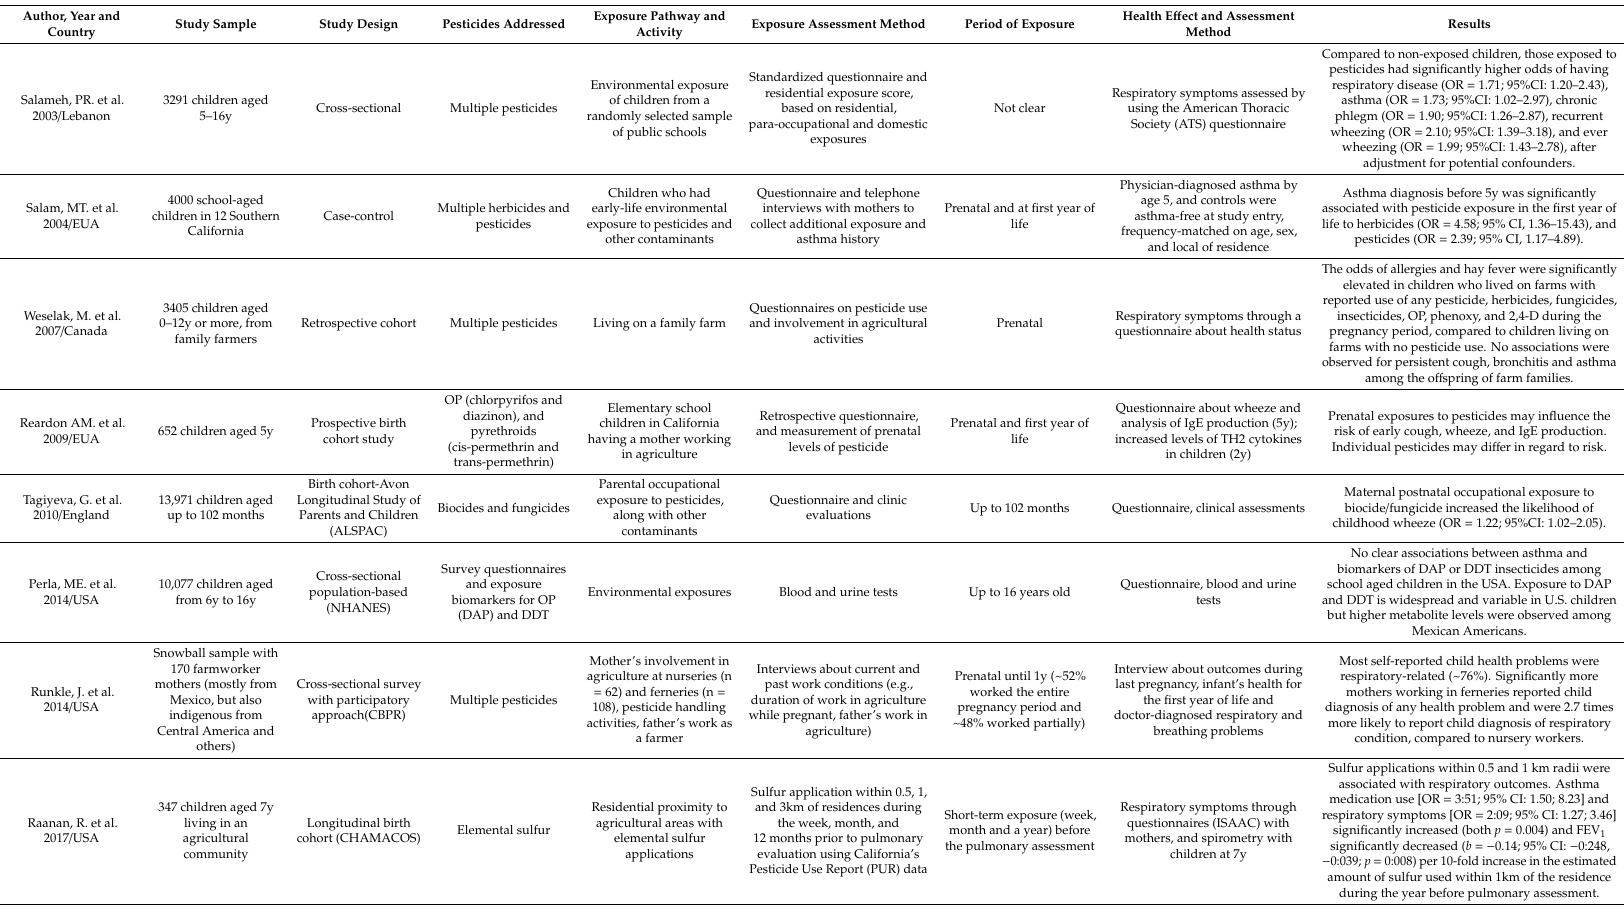
Table 3. Studies on respiratory and allergic e ff ects of multiple pesticides, elemental sulfur, and fumigants in